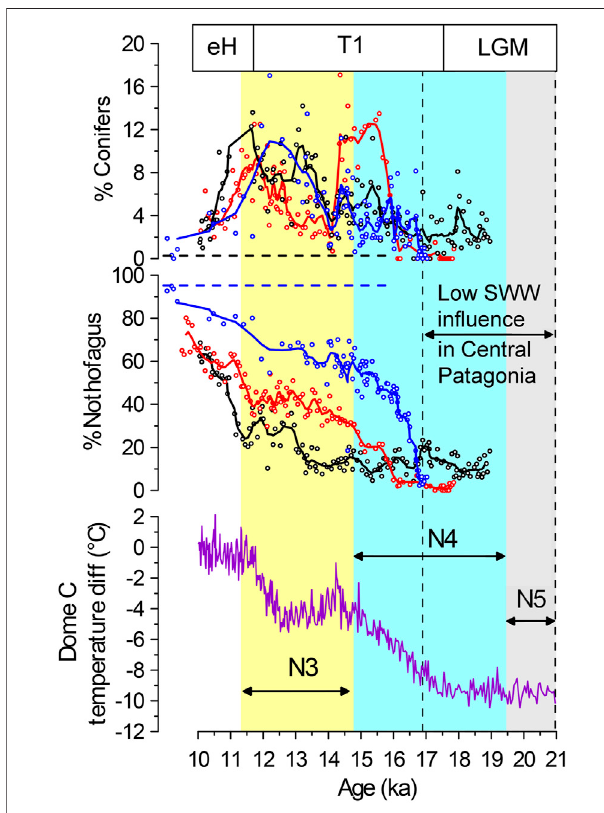
FIGURE 12 | Palynological record from Lago Mellizas (blue line), Lago Edita(blackline),andLagoUnco(redline).Curvesrepresentweightedmoving averages.BlackandbluedashedlinesrepresenttheConifersand Nothofagus average during the last 10,000 years, respectively. The bottom panel shows the temperature variations recorded in the Dome C ice core, Antarctica. The time intervals N5, N4, and N3 are shown as shaded